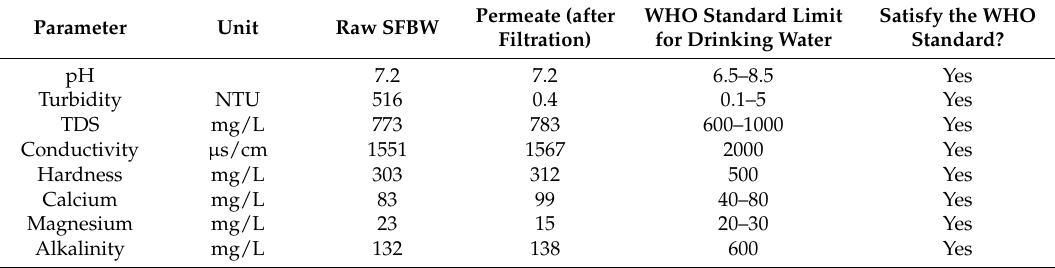
Table 5. Comparison of filtered water characteristics with World Health Organization (WHO) standard limit for drinking.